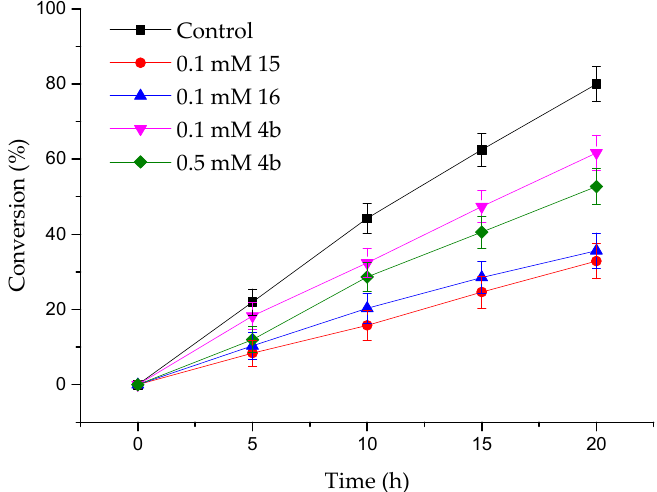
Figure 6. The rate of adenosine deamination in the presence of the nucleosides 15 , 16 , and 4b (control—adenosine). All reactions were performed in 1 mL 20 mM potassium phosphate (pH 7.0) at 25 °C. The reaction progress was monitored by HPLC. Reaction mixtures contained adenosine (0.26 mg, 0.1 mmol), 15 , 16 (0.3 mg, 0.1 mmol), or 4b (0.38 mg, 0.1 mmol) and 0.23 units of recombinant E. coli ADA. The measurement error did not exceed 5%.